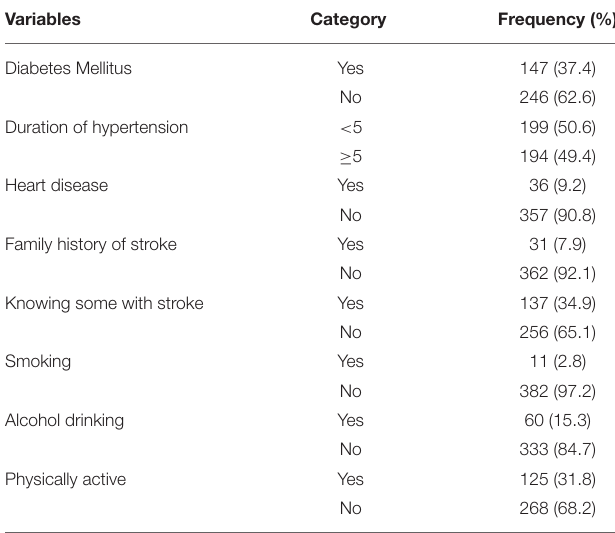
TABLE 2 | Clinical and behavioral characteristics of participants attending in chronic illness follow-up Clinic of University of Gondar Comprehensive Specialized Hospital, Northwest, Ethiopia, 2021 ( n = 393).